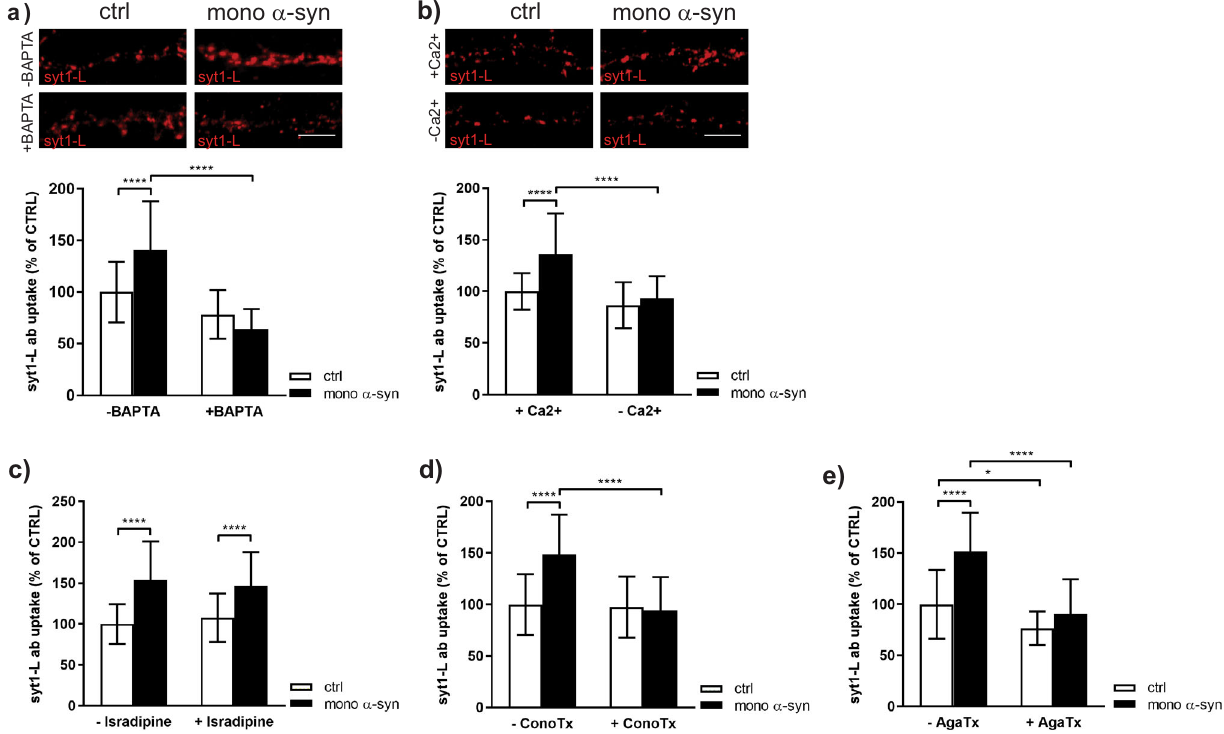
Fig. 3 α -synuclein-induced presynaptic potentiation requires a direct Ca 2 + in fl ux through N-type VGCCs. a Representative images and statistical analysis of network-activity driven syt1L-ab uptake in primary cortical neurons treated with control solution (ctrl) or 500 nM of mono α -syn in the absence or presence of BAPTA-AM (10 µM). Data originate from three independent experiments. Number of analyzed cells: N = 31 ctrl; N = 33 mono α -syn; N = 29 BAPTA; N = 25 BAPTA/mono α -syn. Within each experiment the intensity values of treated cells were normalized to the mean intensity value of the control group (ctrl) and expressed as mean ± SD. Statistical signi fi cance was assessed using two- way ANOVA followed by Tukey ’ s post hoc test. Interaction F (1,114) = 20.59, p < 0.0001; mono α -syn F = 4.81, p < 0.0303; BAPTA-AM F = 66.10, p < 0.0001. **** p < 0.0001. Scale bar 5 µm. b Representative images and statistical analysis of network-activity driven syt1L-ab uptake in primary cortical neurons that are during the treatment with control solution (ctrl) or 500 nM of mono α -syn kept either in normal